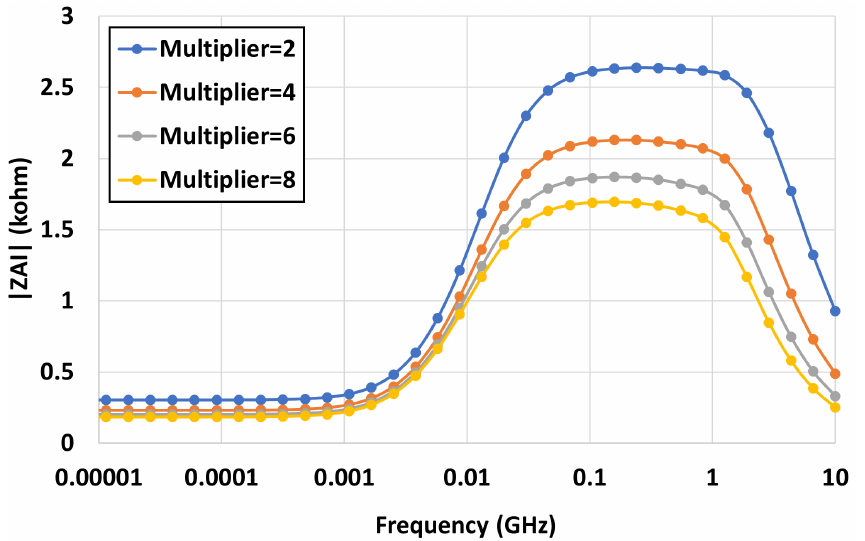
Figure 7. Magnitude of Z AI for different W/L ratio multipliers of transistor M AI . The unit W/L ratio is